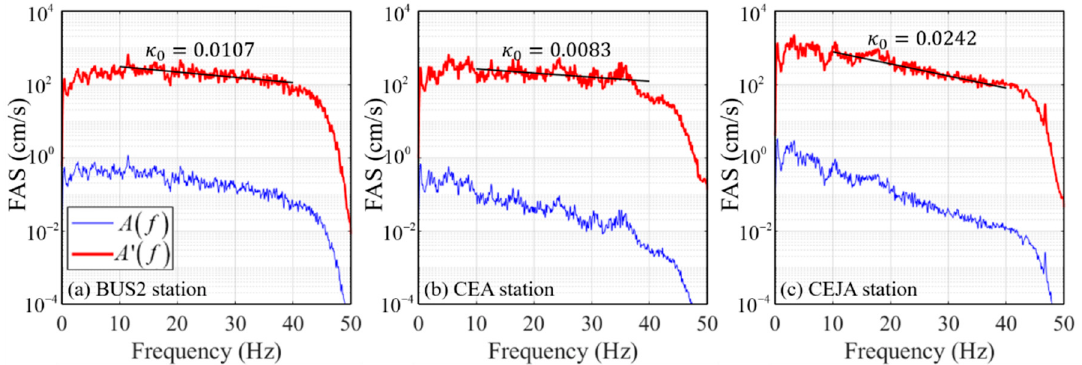
Figure 6. A ( f ) , A ( f ) (cid:48) , and κ 0 values of three sample stations: ( a ) BUS2 station, ( b ) CEA station, ( c ) CEJA station.